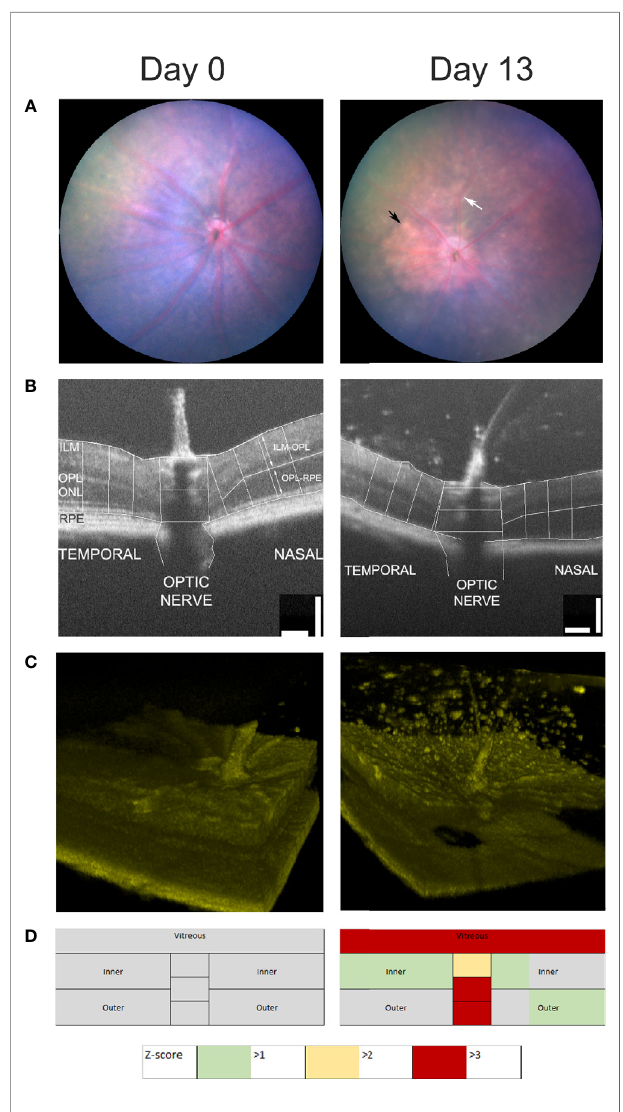
FIGURE 4 | Multimodal analysis of EAU. Mouse eyes were imaged at day 0 and day 13 after the induction of EAU and one representative image of the same eye is shown (A – C) . Clinical disease can be assessed by photography (A) , measurements of retinal thickness and optic nerve diameter at three points from the temporal, nasal and optic nerve regions of the OCT B-scans (B) , 3D-reconstuction of retinal in fi ltrate (C) and summary data of retinal scores from all groups (D) . Summary scores are assembled from unsupervised quantitative assessment of vitreal involvement, manual segmentation and measurement of inner and outer layer thickness and optic nerve diameter transformed and represented as